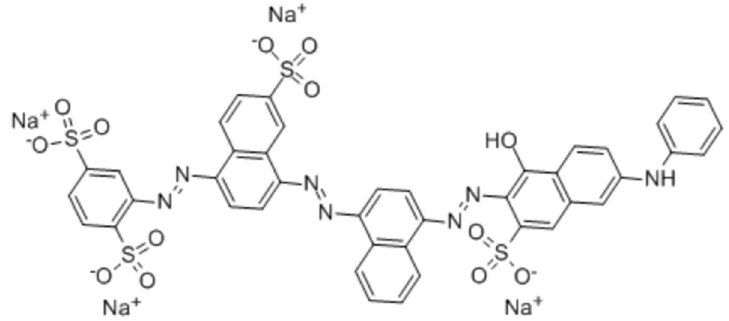
Figure 1. The molecular structure of DB78.